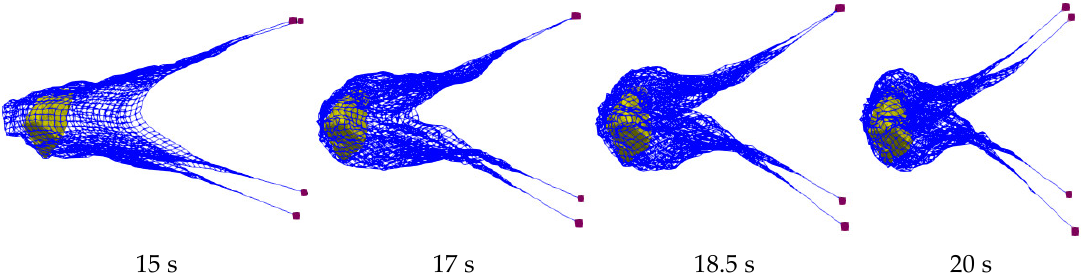
Figure 5. The post-capture process with the presented active control